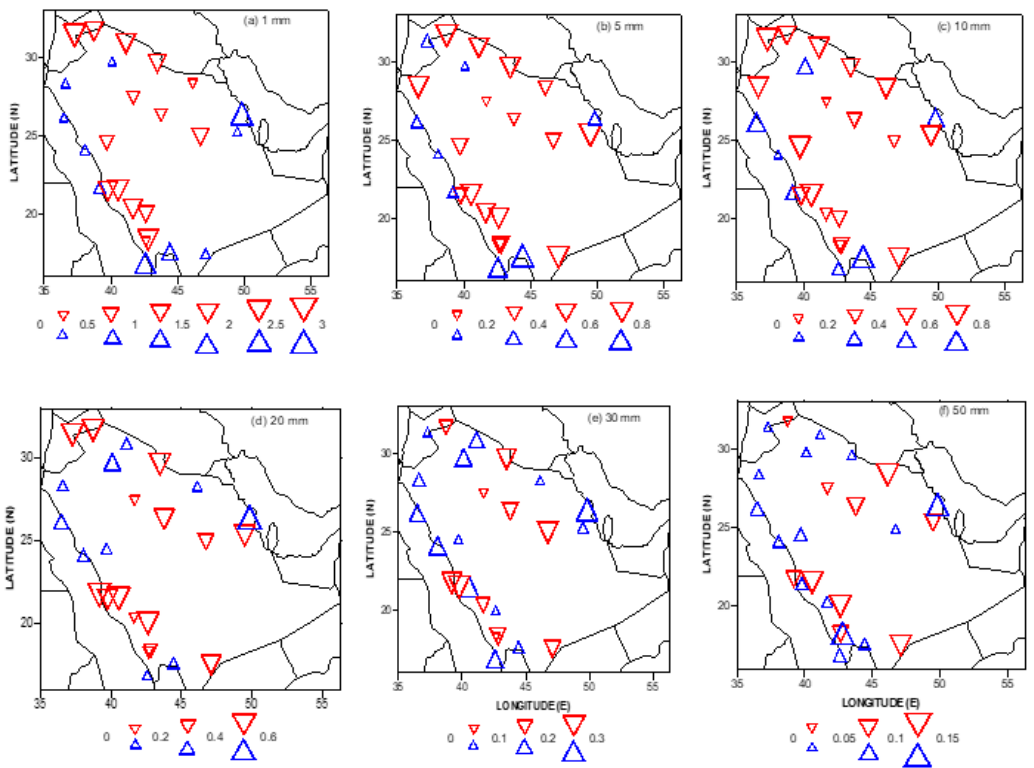
Figure 8. Trends (mm decade − 1 ) of rainfall extremes for thresholds: ( a ) ≥ 1, ( b ) ≥ 5, ( c ) ≥ 10, ( d ) ≥ 20, ( e ) ≥ 30, and ( f ) ≥ 50 mm for the period 1978–2019. The upward (blue) and downward (red) triangles represent increasing and decreasing trends, respectively. Note that the scales of all the panels are not